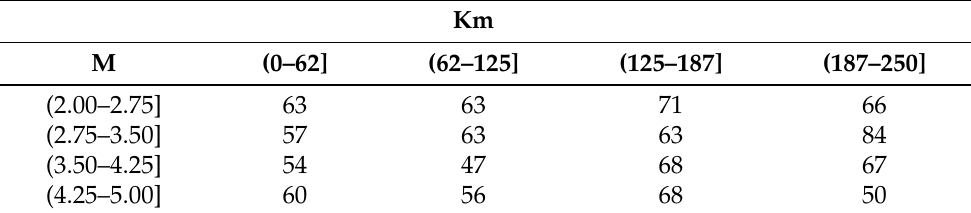
Table 1. Number of waveforms selected for the 16 simulated scenarios.